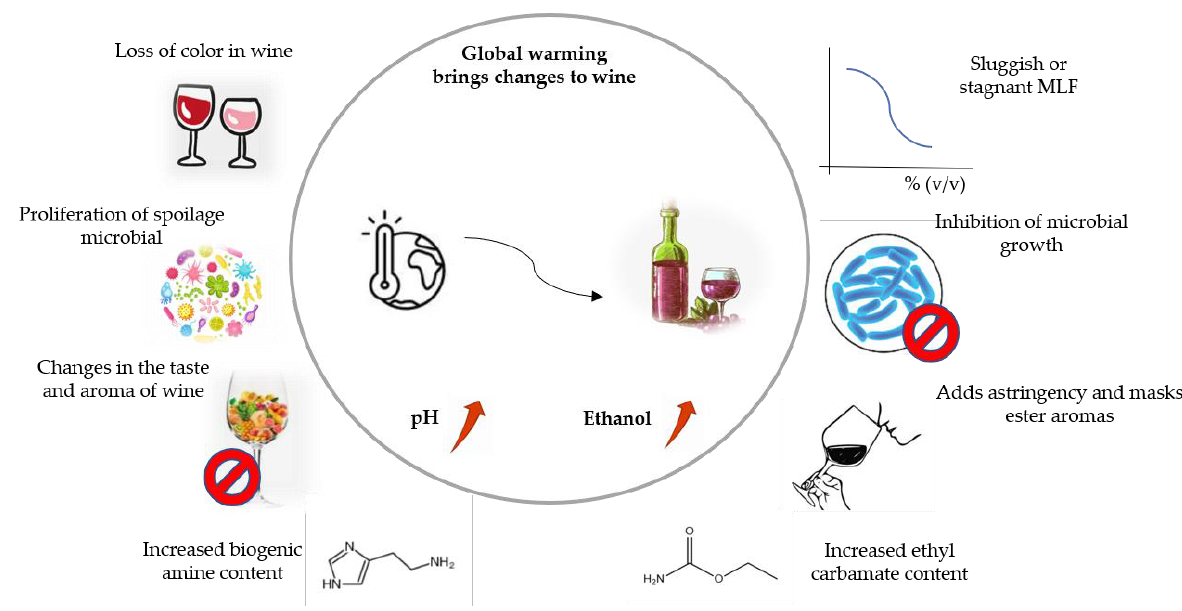
Figure 1. Effects of climate change on wine quality.